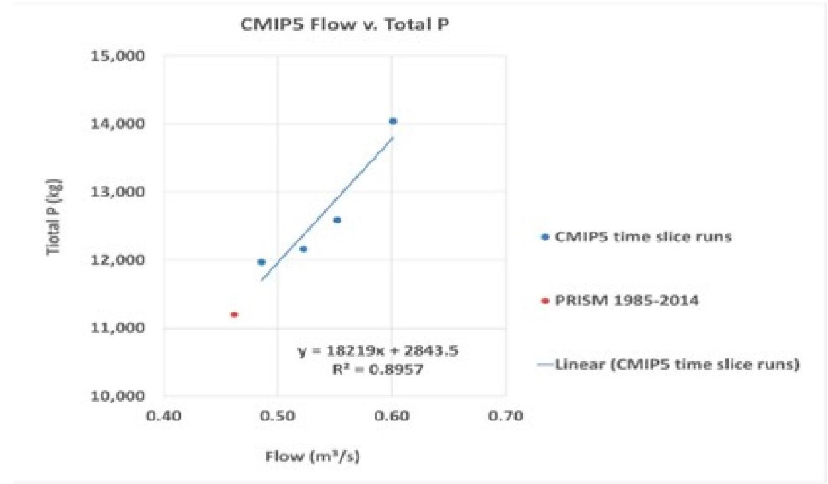
Figure 16. Average of 20 CMIP5 GCMs flow vs. total phosphorus (2018–2100).